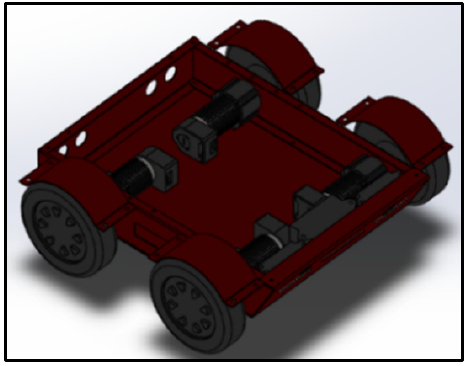
Figure 3. Chassis structure diagram.